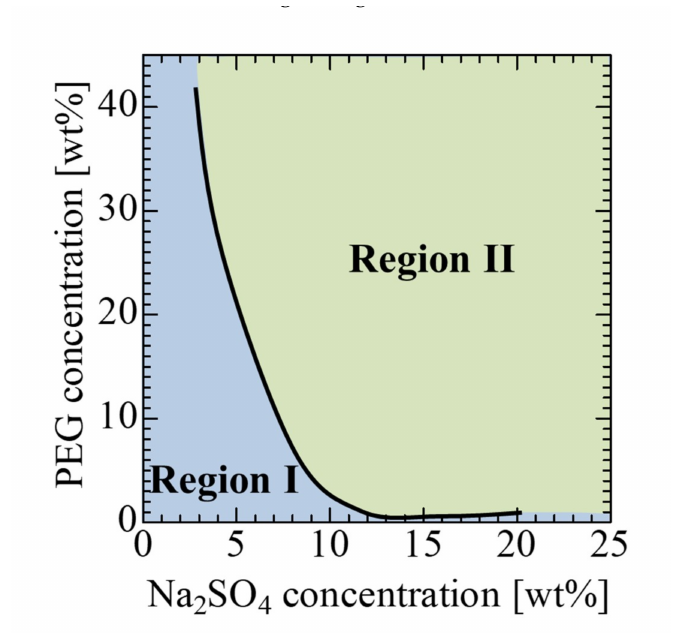
Figure 3. Phase diagram of polyethylene glycol (PEG)–Na 2 SO 4 –water